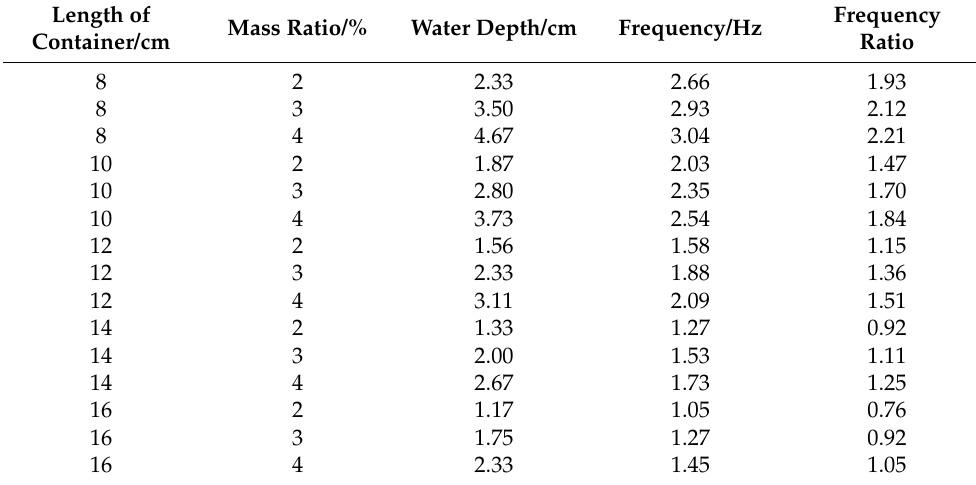
Table 2. Parameters of the KV-TLD. Length of Mass Ratio/% Water Depth/cm Container/cm